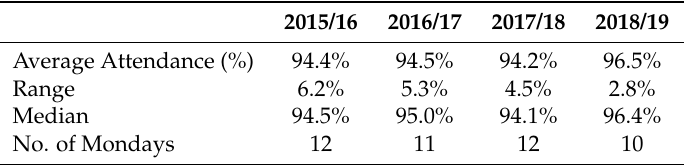
Table 6. Comparison of Monday Summer term attendance data for I2.